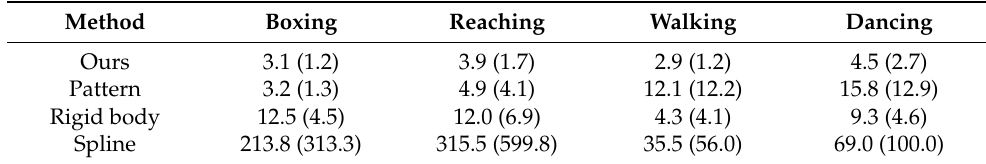
Table 5. Summary of the performance per activity. Mean (standard deviation) of RMSE are presented, in